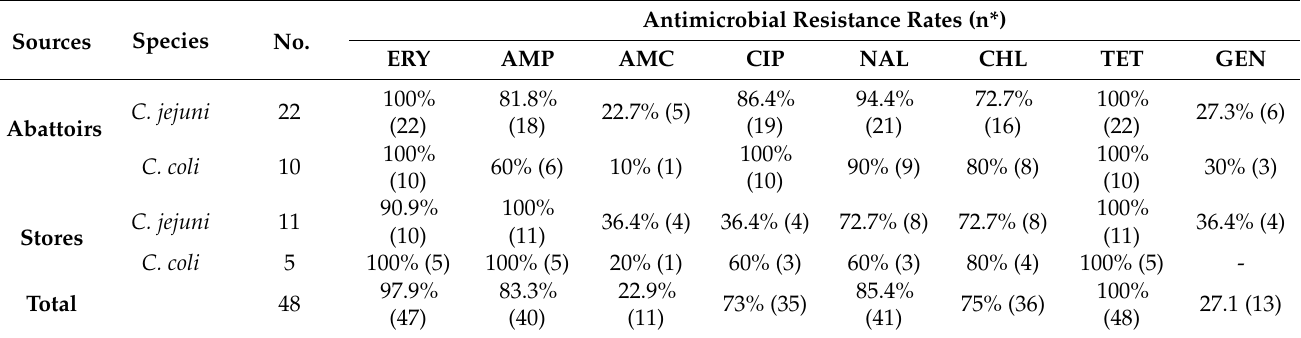
Table 2. Antimicrobial resistance rates in C. jejuni and C. coli